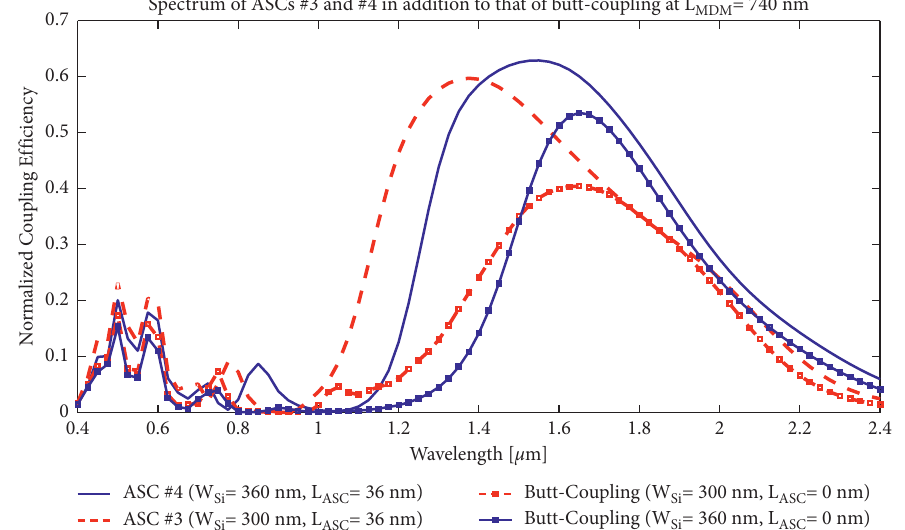
Figure 3: The spectrum of the proposed ASCs #3 and #4 in addition to that of butt coupling with and without the W